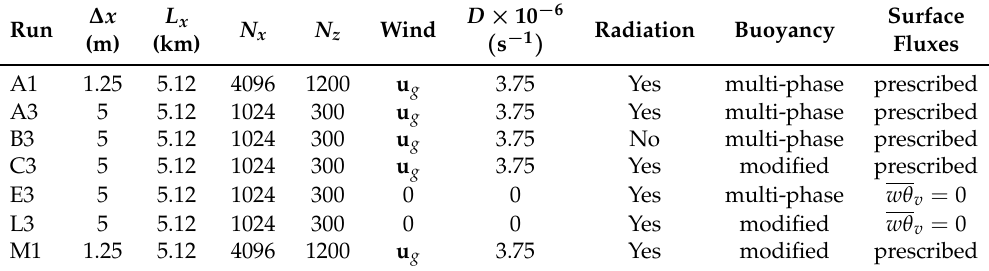
Table 1. Summary of the cases simulated. The grid spacing is denoted by ∆ x . For all runs, the grid is homogeneous ∆ x = ∆ y = ∆ z . The number of horizontal and vertical grid points are N x = N y and N z , respectively. “Wind” corresponds to forcing with the geostrophic wind u g or no wind (i.e., no mean surface shear), and D is the large-scale divergence. The case-specific parameterization of [39] is used for the net longwave radiative flux, except Case B3 which has null radiative flux at all model levels. Cases C3, L3, and M1 use a modified buoyancy variable (Equation (3)). Surface sensible and latent heat fluxes are denoted by “prescribed” when